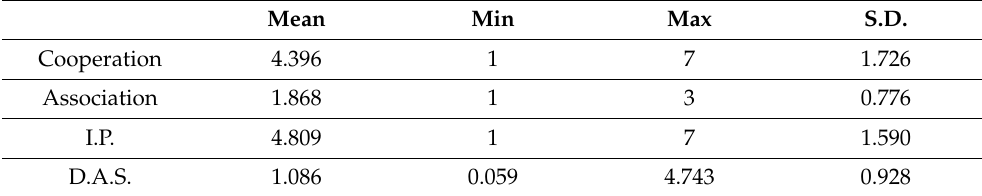
Table 3. Descriptive statistic of the data obtained in the